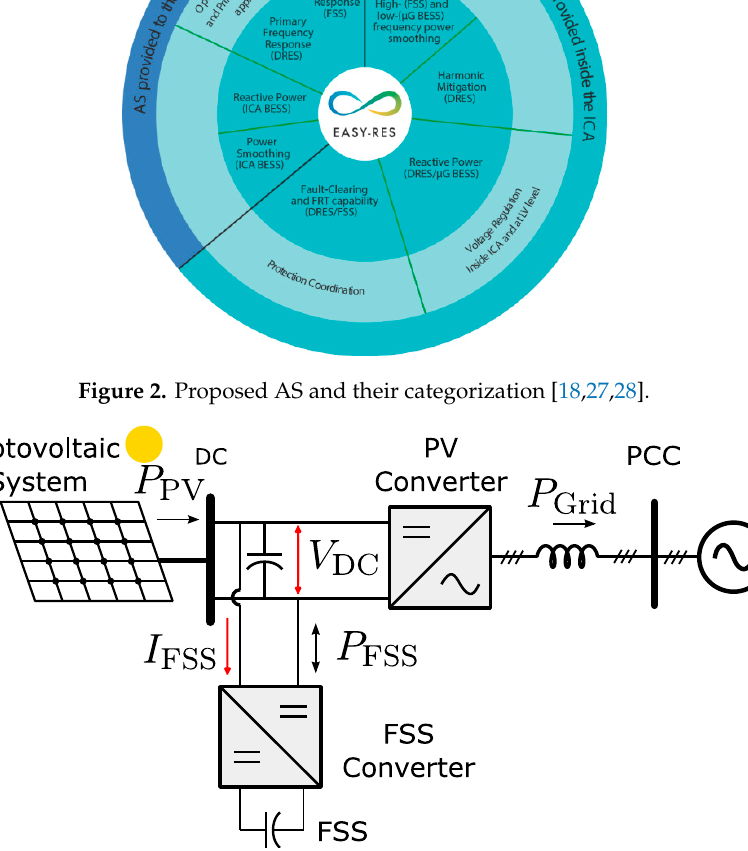
Figure 3. DRES and FSS based on supercapacitor bank for inertial response, FRT and ramp rate limitation in PV plants.